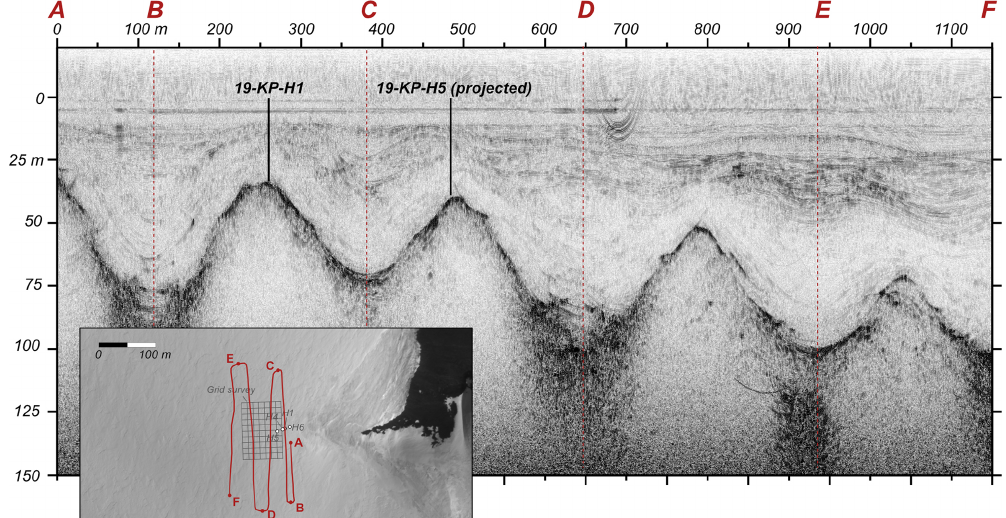
Figure 5. Example 100MHz radar profile collected prior to drilling in 2019–2020 that crosses the subglacial portion of Kay Peak Ridge four times (see inset map). The profile has been distance normalized, and a Kirchhoff migration was applied to improve bedrock depth estimates. Core 19-KP-H1 lies on the radar line, as shown, and the nearest projected location of 19-KP-H5 is also shown. The projected locations of two other cores, 19-KP-H4 and 19-KP-H6, would be near 19-KP-H1 in this figure. The location of the grid survey that was also used for drill site selection is shown in